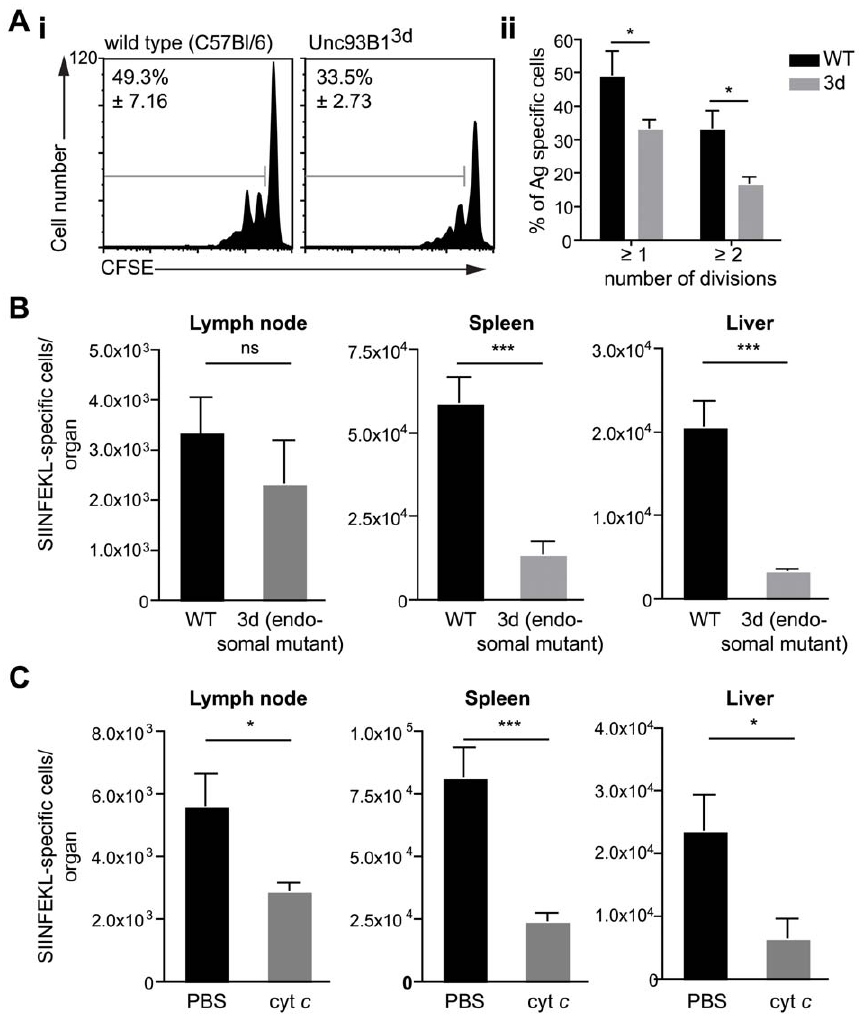
Figure 3. Antigen presentation by DCs occurs via the endosome-to-cytosol pathway. A. i. DCs were purified from the ear draining LN of C57Bl/6 (wild type) or Unc93B1 3d animals 2 days after immunization with 5 6 10 4 P. berghei CS 5M sporozoites/ear and incubated with CFSE labeled SIINFEKL specific trangenic cells. i Representative CFSE profiles of the transgenic cells 3 days after immunization values at top left are the percent of cells that have divided (mean 6 SEM). ii. Mean number of cells that had divided at least one or twice in 3 independent experiments after incubation with DCs from wild type (black bars) or 3d mice (gray bars) (mean 6 SEM; * = P , 0.05; for each group in each experiment pooled DCs from 6–8 immunized animals were used). B. 3d (endosomal mutant) and C57Bl/6 mice received 2 6 10 3 naı¨ve SIINFEKL-specific cells prior to being fed on by 10– 20 P. berghei CS 5M infected mosquitoes. 10 days later the mice were sacrificed and the expansion of SIINFEKL-specific cells in the spleen and liver determined. Data are pooled from 2 similar experiments (mean 6 SEM; n=6; *** = P , 0.001). C. C57Bl/6 mice received 2 6 10 3 naı¨ve SIINFEKL-specific cells prior to being fed on by 10–20 P. berghei CS 5M infected mosquitoes. Treated mice received 15 mg of horse cyt c (Sigma) for 3 days starting on the day before immunization, control mice received vehicle alone (PBS). 10 days later the mice were sacrificed and the expansion of SIINFEKL-specific cells in the spleen and liver determined. Data are pooled from 2 similar experiments (mean 6 SEM; n=6).